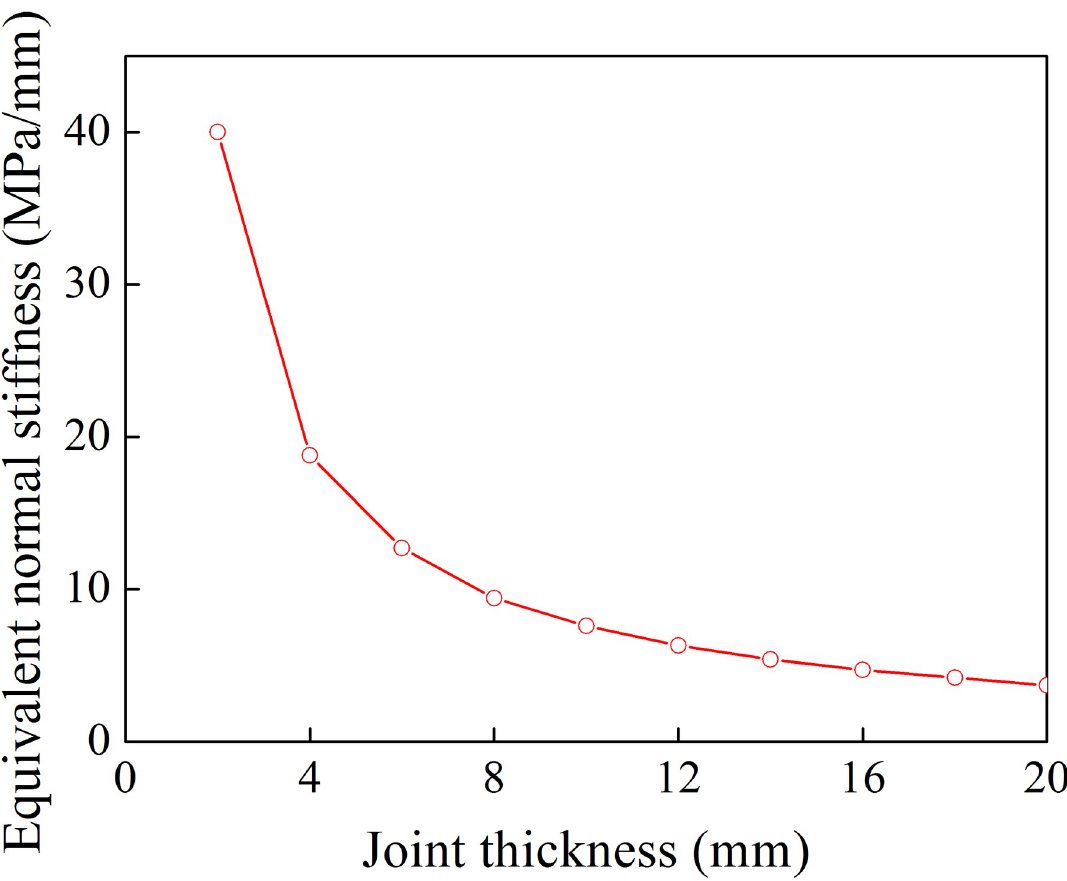
Fig 5. Equivalent normal stiffness of filled